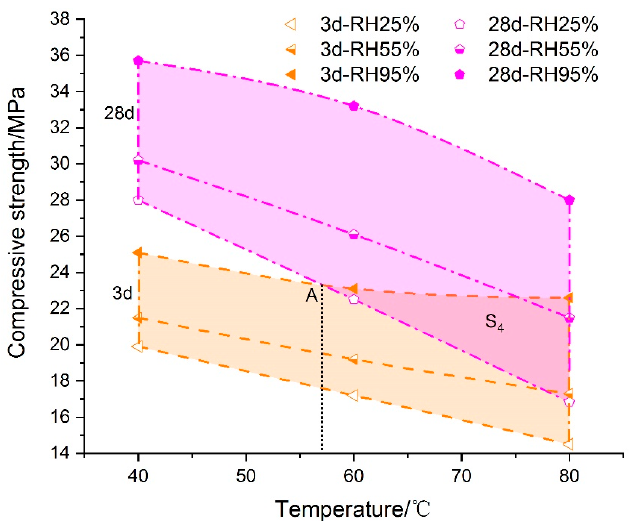
Figure 6. The impact of curing age on the compressive strength of grouting material.